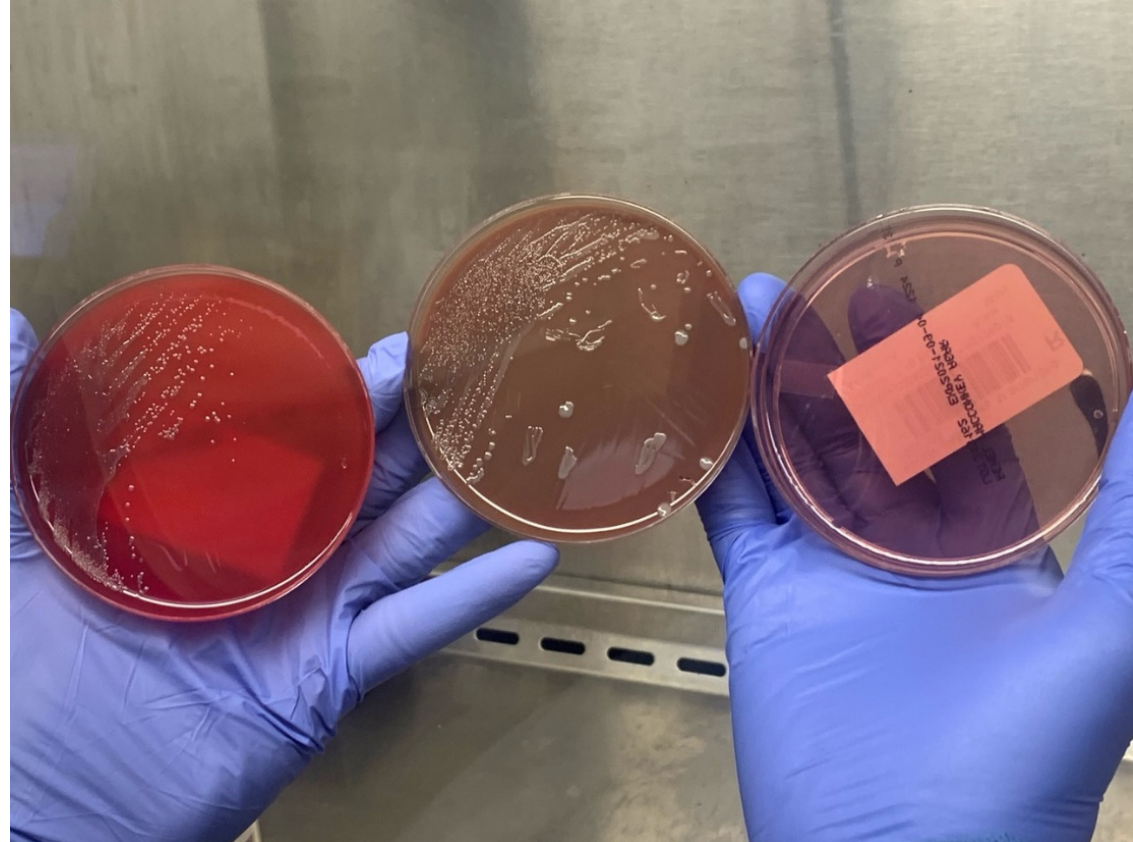
Figure 2. Small, slow-growing bacterial colonies, with augmented growth on chocolate agar and no growth on MacConkey agar.